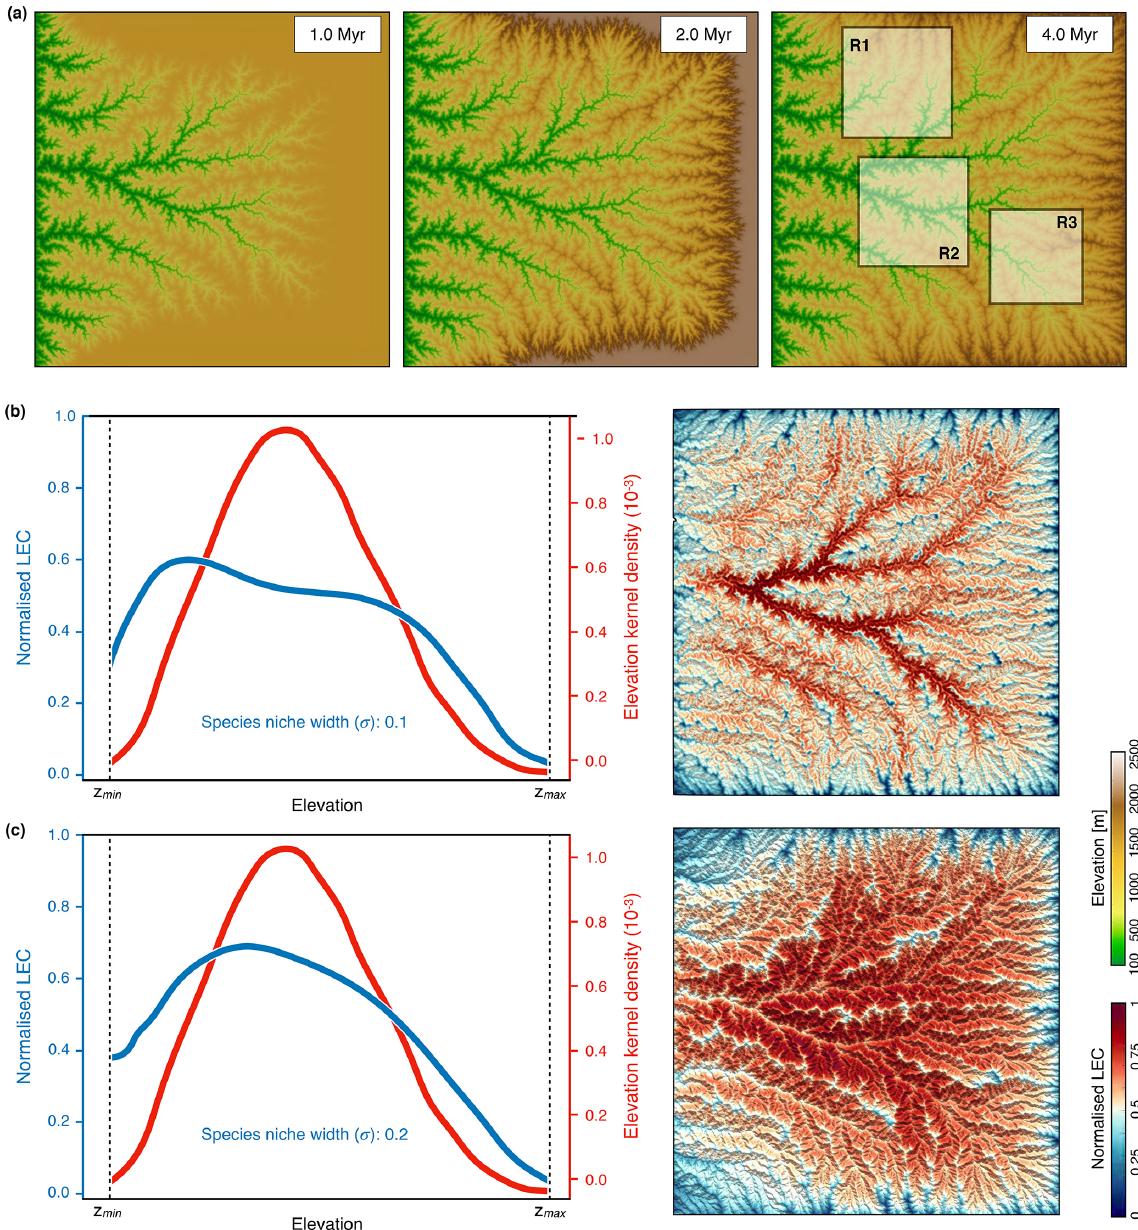
Figure 6. Outputs from the modified uniform precipitation model with only one fixed boundary along the western border of the simulated domain. (a) Maps of the evolution of the landscape at three time steps during the growth phase (induced by a uniform uplift of 1mmyr − 1 ). Panels (b) and (c) show the results obtained with two ratios for σ/ ( z max − z min ) of 0.1 and 0.2, respectively. In both cases, we present on the left the average line of LEC within elevational bands (blue lines) and the elevation kernel density (red lines) for the entire simulated domain at steady state (5Myr); on the right is the corresponding normalised connectivity